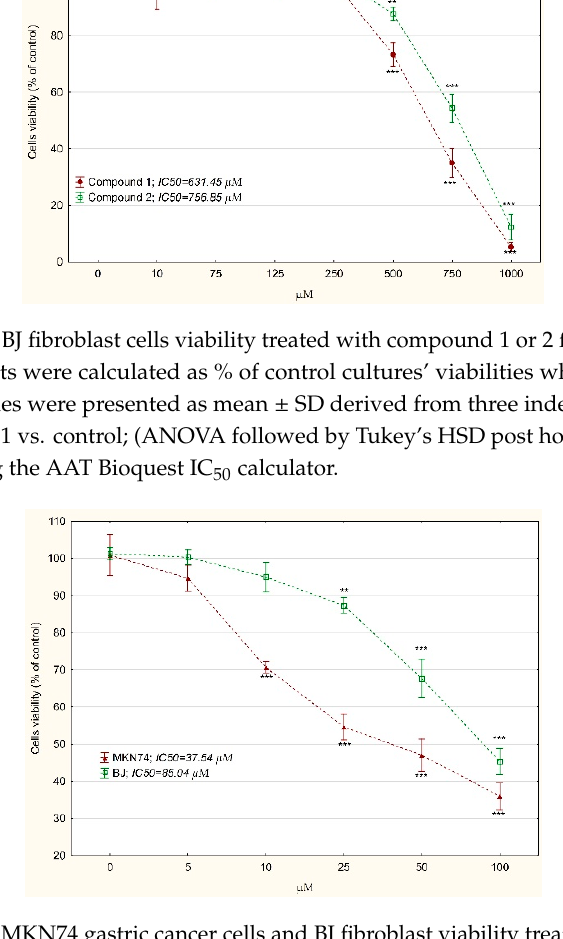
for 24 h determined by MTT assay. The results were calculated as % of control cultures’ viabilities